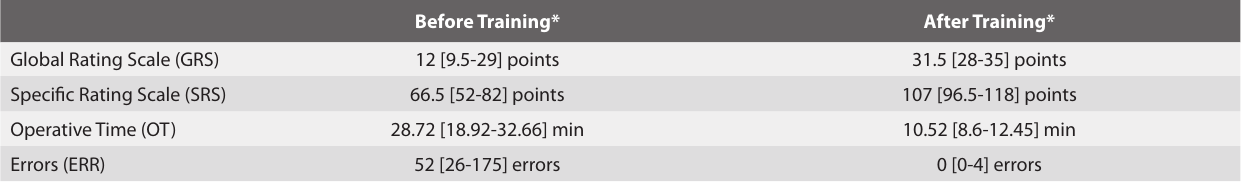
Table 4. Junior residents performance before and after the training